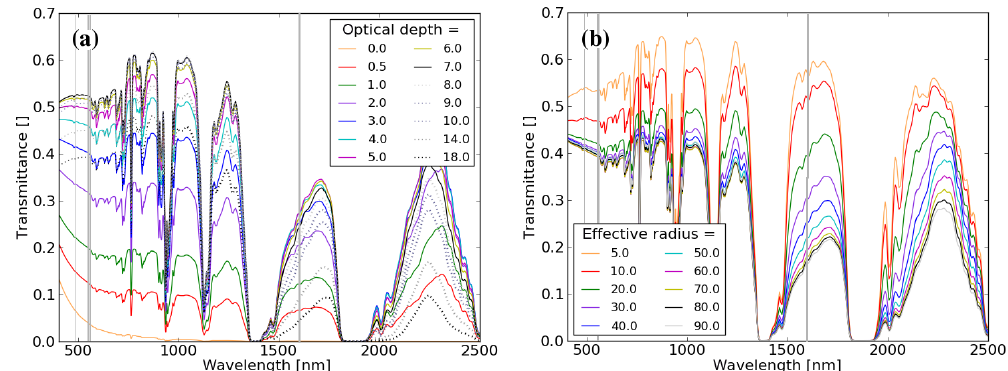
Figure 3. Ice cloud transmittance simulations at specMACS spectral sensitivity for θ 0 = 36 ◦ , θ v = 0 ◦ , φ rel = 180 ◦ and “Baum-like” habit mixture: variation of (a) optical thickness (r eff = 40µm) and (b) effective radius ( τ = 3.0). Thin grey vertical lines indicate 485 and 560nm; thick grey lines indicate 550 and 1600nm used in the retrieval